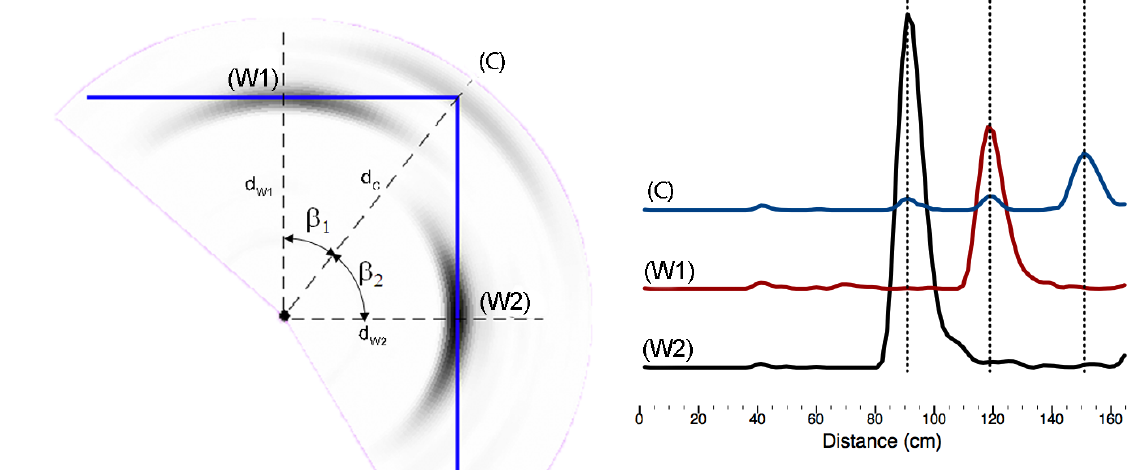
Figure 4. Echoes returned from the corner of Figure 3. Left: 2D representation of the circular scan. Right: received echoes corresponding to the three peak amplitudes ( W all W all and Corner 2